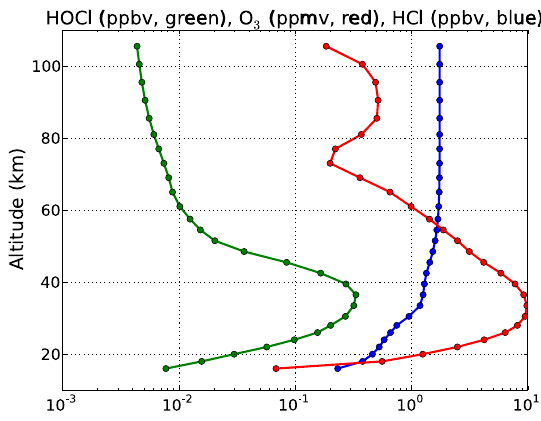
Fig. 5. VMR profiles of HOCl (green, ppbv), O 3 (red, ppmv) and HCl (blue, ppbv) used for the sensitivity analysis.